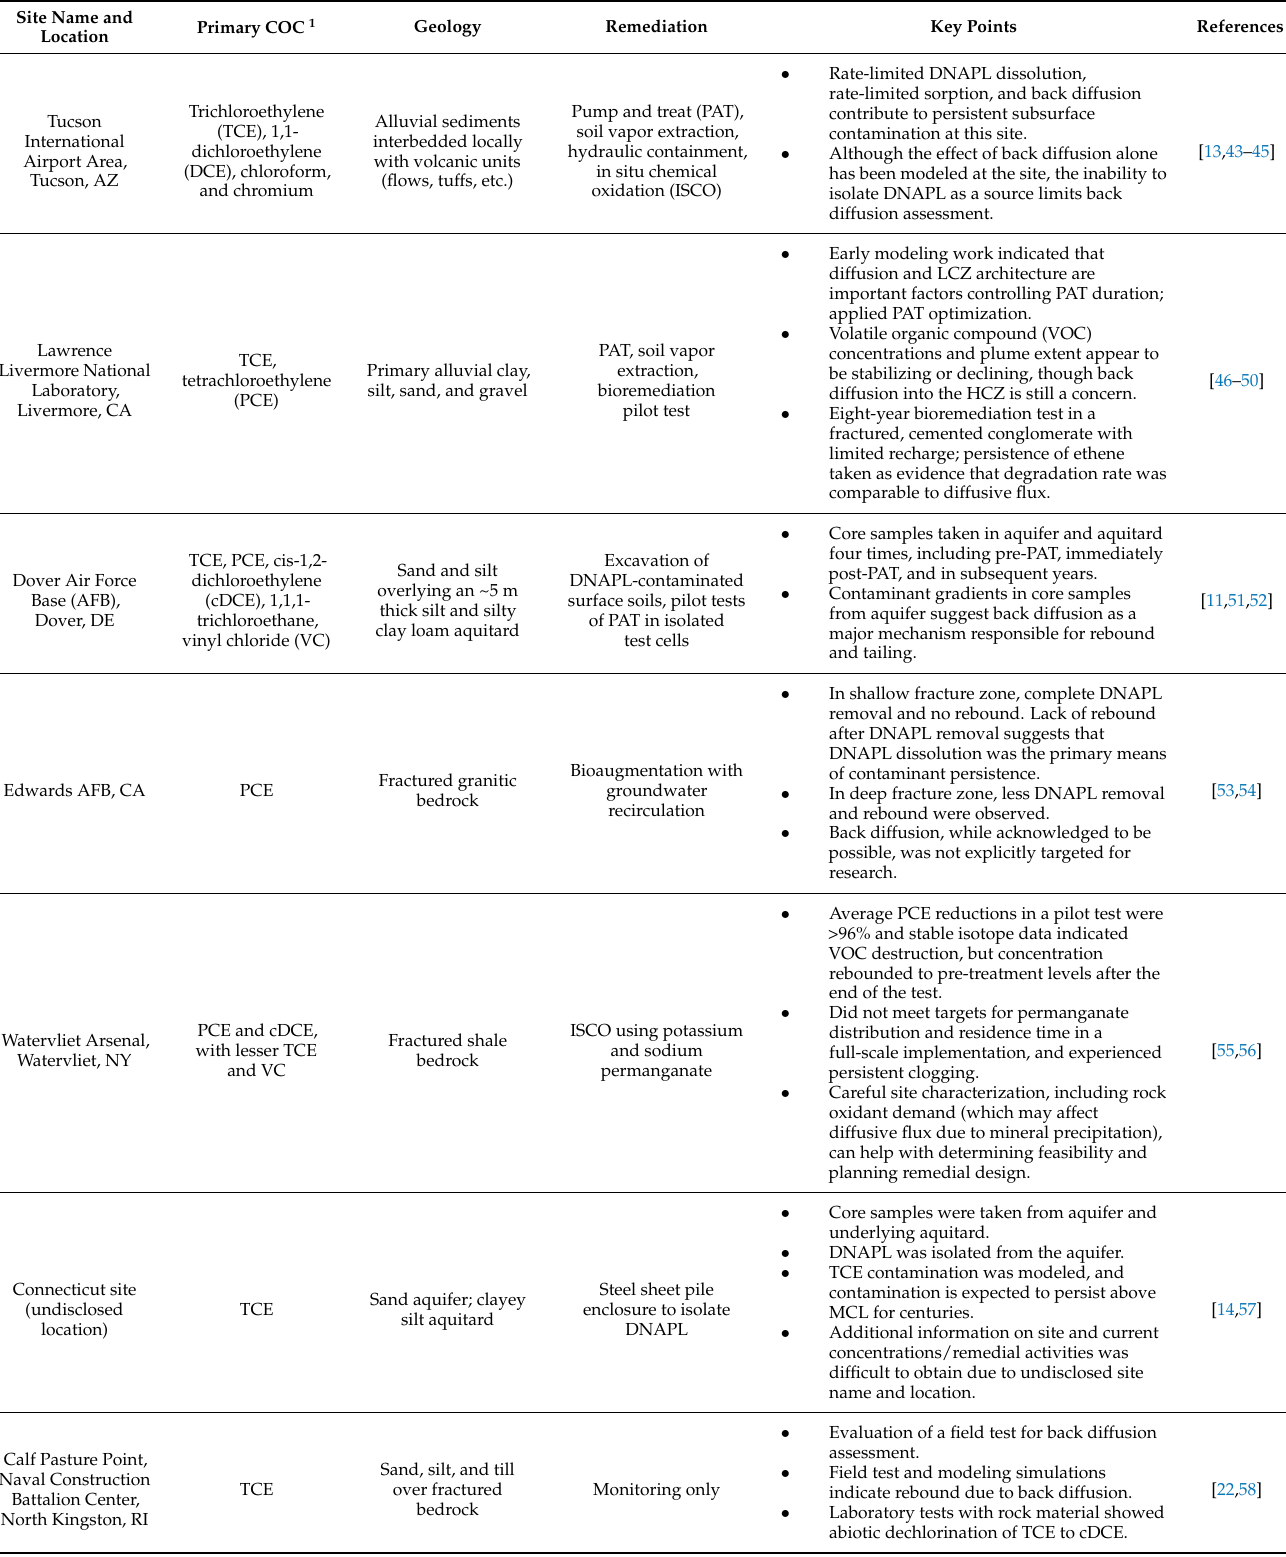
Table 1. Summary of sites exhibiting back